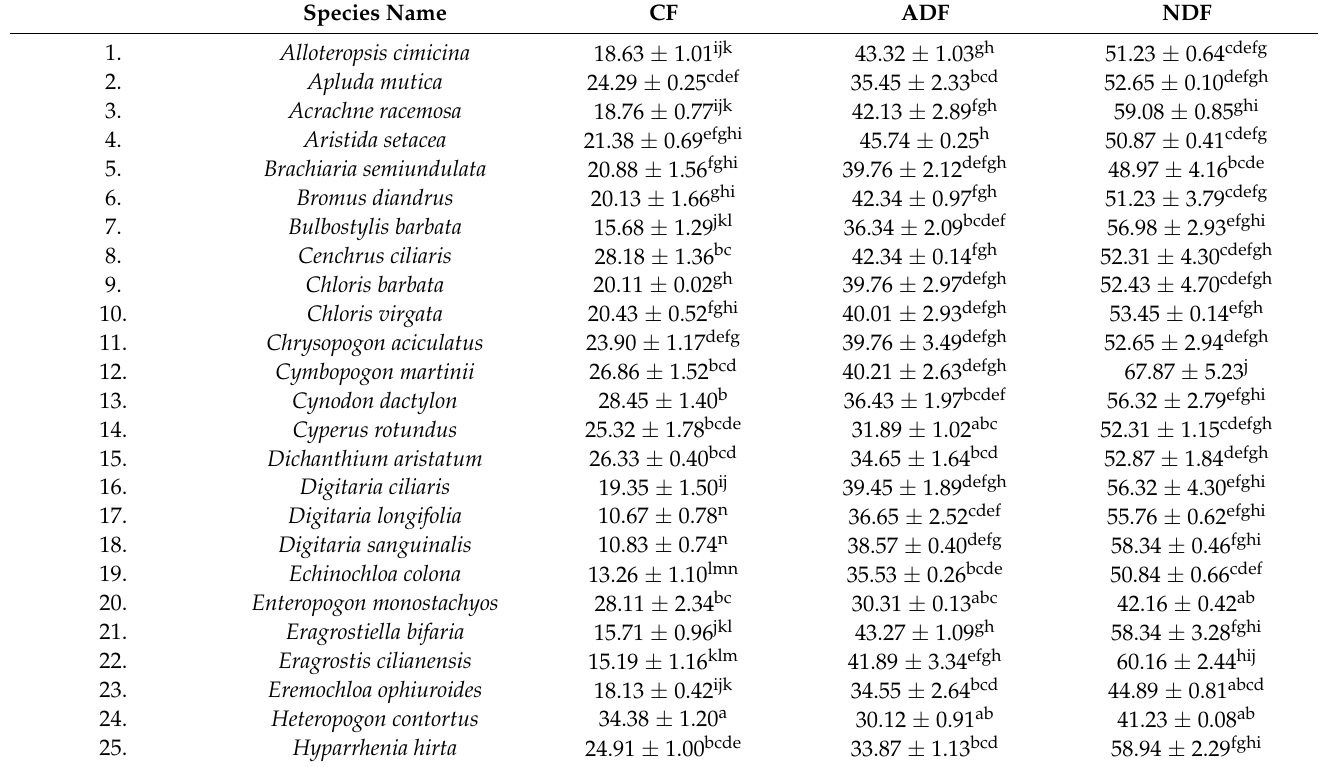
Table 2. Crude fibre and Detergent fibre components of the grass fodder